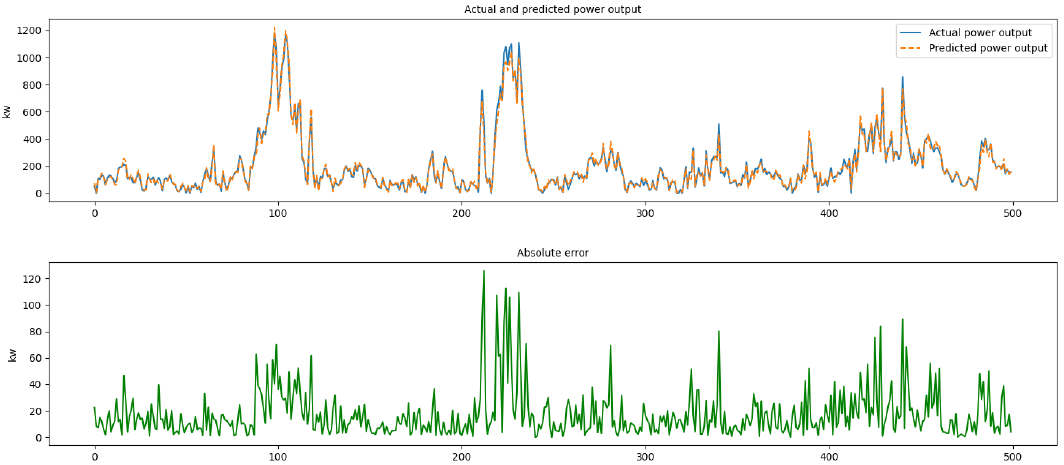
Figure 7. Power prediction on test data (#6, top 500 test points). Energies 2020 , 13 , x FOR PEER REVIEW